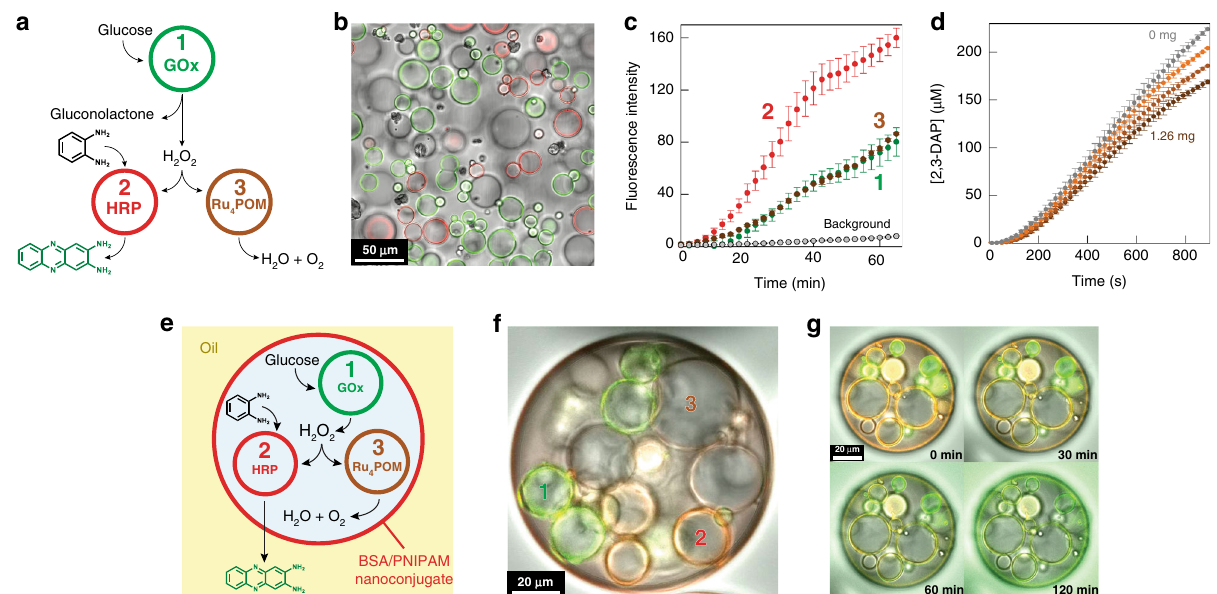
Fig. 4 Chemical signaling in distributed and compartmentalized multi-catalytic protocell communities. a Scheme showing a ternary population comprising a single transmitter protocell (FITC-tagged GOx-containing PTA-CVs; green circle, 1) and two competitive receiver protocells (RITC-tagged HRP-containing PTA-CVs (red circle, 2) and untagged Ru 4 PCVs (brown circle, 3). A glucose input generates a protocell-mediated H 2 O 2 signal that in the presence of o-PD activates peroxidase and synzyme activities simultaneously to give two competitive outputs (green fl uorescent 2,3-DAP or O 2 , respectively). b Superimposed bright fi eld and fl uorescence confocal microscopy image showing aqueous mixture of 1 (green fl uorescence), 2 (red fl uorescence) and 3 (no fl uorescence) in PBS buffer (0.01M, pH 6.5) prior to addition of glucose. Relative numbers of protocells was 1:1:1. c Plots of time- dependent changes in green fl uorescence intensity associated with 2,3-DAP production and transfer in different individual protocells shown in b after addition of glucose ( fi nal concentration, 50 mM) (see Supplementary Movie 3). On receipt of the H 2 O 2 signal, production of 2,3-DAP occurs in 2 (red data points) followed by equal rates of diffusive transfer and capture of 2,3-DAP by protocells 1 (green) and 3 (brown). Minimal background green fl uorescence is observed (gray plot). Error bars: standard deviation. d Graph showing the time-dependent generation of 2,3-DAP as determined by plate reader measurements on dispersed ternary communities comprising constant numbers of 1 (0.08 mg) and 2 (0.08 mg), and increasing numbers of 3 (Ru 4 PCVs; 0 (gray plot), 0.23 (light brown), 0.63 (brown), and 1.26 mg (dark brown). Reactions were initiated by addition of glucose and o-PD at fi nal concentrations of 50 mM and 1 mM, respectively. Increased numbers of Ru 4 PCVs progressively decrease the production of 2,3-DAP. Error bars: standard deviation. e Scheme showing compartmentalization of a ternary proto-organelle population capable of operating a parallel signaling cascade within individual water- in-oil emulsion droplet. The emulsion droplets are stabilized by a self-assembled monolayer membrane of a protein-polymer (BSA/PNIPAM) nanoconjugate and serve as a host for the synthetic proto-organelles. f Superimposed bright fi eld and fl uorescence confocal microscopy image of a single water-in-oil emulsion droplet containing an aqueous mixture of protocells 1 (green fl uorescence), 2 (red fl uorescence) and 3 (no fl uorescence). g As shown in f but at various reaction times ( t = 0, 30, 60, and 120 min) and in the presence of glucose and o-PD in the water phase (50 and 1 mM, respectively). The video time-shots show a progressive increase in green fl uorescence within protocells 1, 2, and 3 as well as in the oil phase due to 2,3-DAP production in 2 (see Supplementary Movie